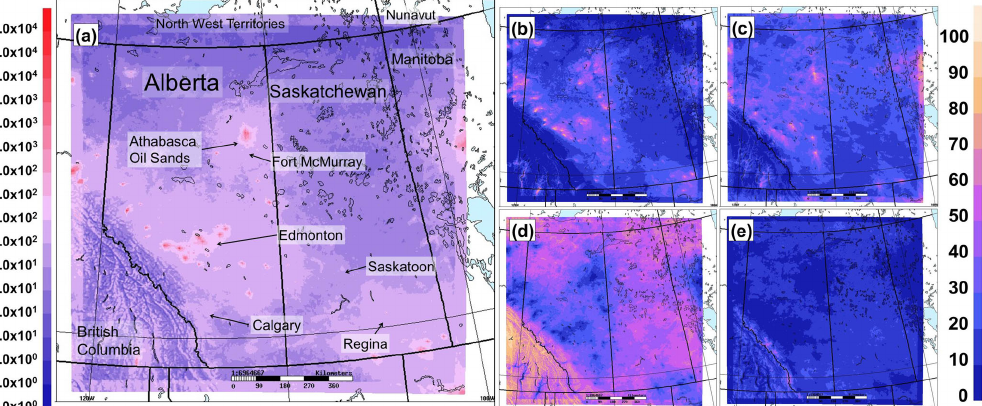
Figure 6. GEM-MACH predictions of total sulfur deposition and its speciation. (a) Total sulfur deposition (eqha − 1 yr − 1 ) and percentages of total sulfur deposition due to (b) SO 2 (dry), (c) HSO −